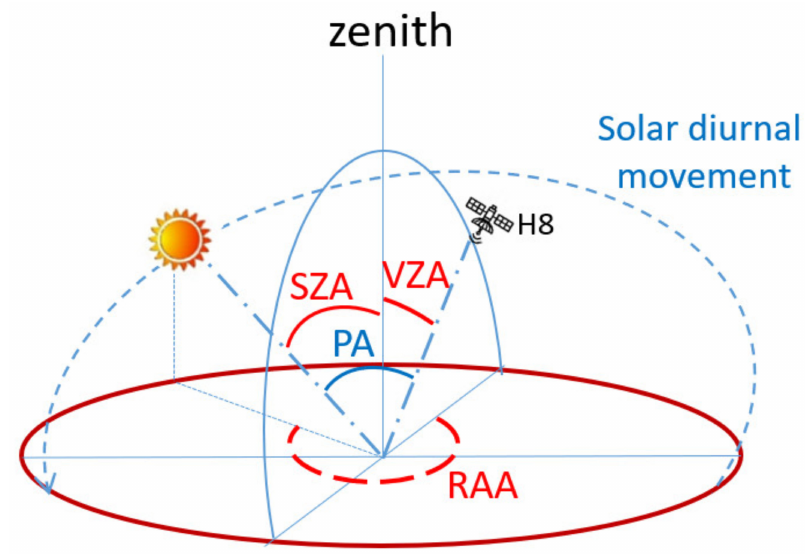
Figure 2. Diagram of Himawari-8 diurnal sun-sensor view geometry variations, with fixed view zenith angle (VZA) and diurnal varying solar zenith angle (SZA) and relative azimuth angle (RAA). The angle between the illumination source and the sensor detector is called the phase angle